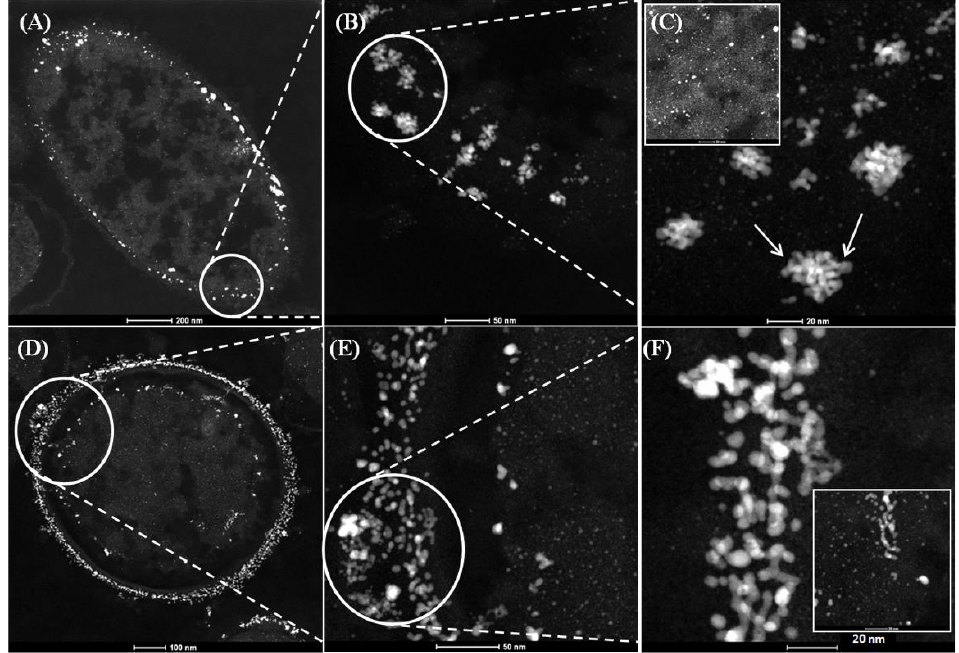
Figure 2. HAADF–STEM micrographs of Pd nanoparticles synthesized using 5 wt% Pd loading (1:20) on D. desulfuricans from 2 mM Na 2 PdCl 4 solution, in 0.01 M HNO 3 using hydrogen as electron donor